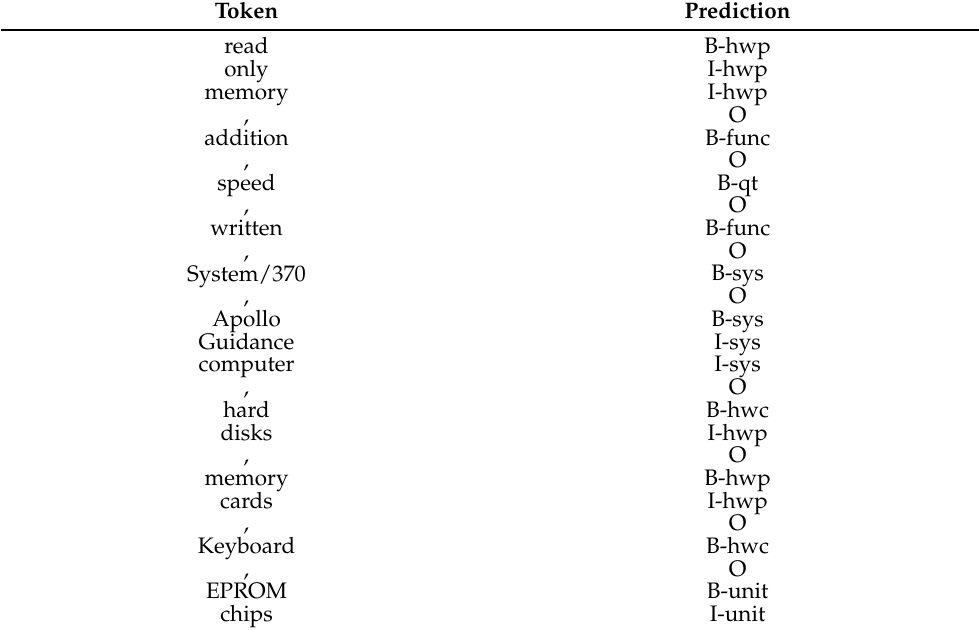
Table 7. Predictions on unseen